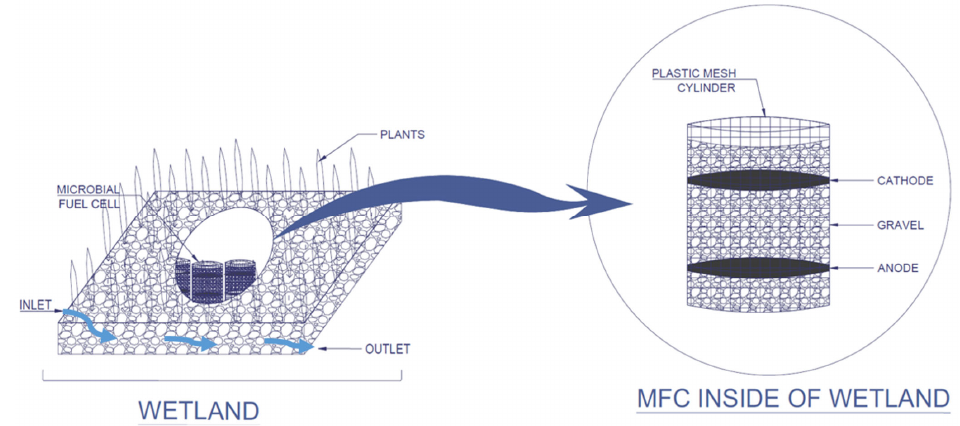
Figure 12. MFC within a horizontal subsurface CW ( adapted from Corbella et al. (2015) [57]). Liu et al. (2019a) [43] designed a vertical ‐ flow CW ‐ MFC (Figure 13) to treat slightly polluted source water. The water contained, on average, 15.5 mg/L COD, 0.17 mg/L total phosphorus (TP), 3.3 mg/L total nitrogen (TN), 0.85 mg/L NH 4+ ‐ N, 1.6 mg/L NO 3 − ‐ N, and 1.11 mg/L NO 2 − ‐ N. This system produced the maximum voltage and power density of 777 mV and 8.05 mW/m 2 , respectively, at an external resistance of 6000 Ω . Denitrification was frequently disturbed. In another study by Liu et al. (2019b) [58], a vertical ‐ flow CW ‐ MFC (Figure 13) was fed swine wastewater after it was treated anaerobically in a biogas tank and an up ‐ flow anaerobic sludge blanket process. An average COD concentration in the influent was 505 mg/L with a range between 324 mg/L and 708 mg/L. To provide a large surface area for the growth of electroactive microbes, a layer of activated carbon was placed at the bottom of the system. This system produced voltage in the range from 598 mV to 713 mV and the largest power densities of 456 mW/m 3 . The ohmic resistance was mainly rooted in the conductivity of electrolytes, electrodes, and surface biofilms [58]. This process produced a Coulombic efficiency of only 0.386%, which may be due to the fact that a large number of microorganisms from the swine wastewater competed with the electrogenic bacteria for organic food in the reactor, resulting in, at least partially, anaerobic digestion reactions [58].